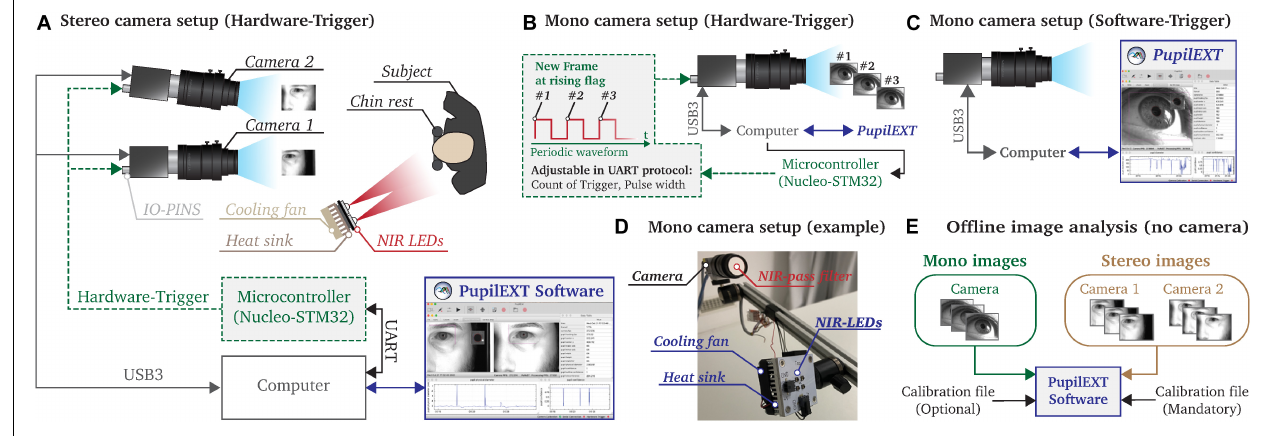
FIGURE 3 | Illustration of the possible measurement configurations that can be realized with the PupilExt software. (A) In stereo vision mode, two cameras are connected to the computer via USB3.0. A microcontroller is connected to the IO-pins of the camera, which triggers a synchronized image acquisition on both cameras. We recommend using a Nucleo-STM32 microcontroller since the provided source code can be used to flash the electronic. We implemented a UART communication protocol in the microcontroller so that PupilExt can automatically control and synchronize the stereo camera system via the connected hardware, via the electronics. (B) In mono camera vision mode, it is possible to control the image acquisition by an external hardware trigger, which has the advantage that the recording time can be set accurately. When capturing multi-image sequences, the hardware trigger consists of a square wave signal in which each rising edge triggers an image acquisition. (C) The use of a microcontroller is optional when connecting a single camera. Without the use of a microcontroller, a software trigger is used for image acquisition. (D) Prototype of a pupillometry set-up with a single camera and respective near-infrared (NIR) illumination unit. (E) The software PupilExt can be used without connected cameras in an offline mode to detect the pupil diameter from externally captured images.